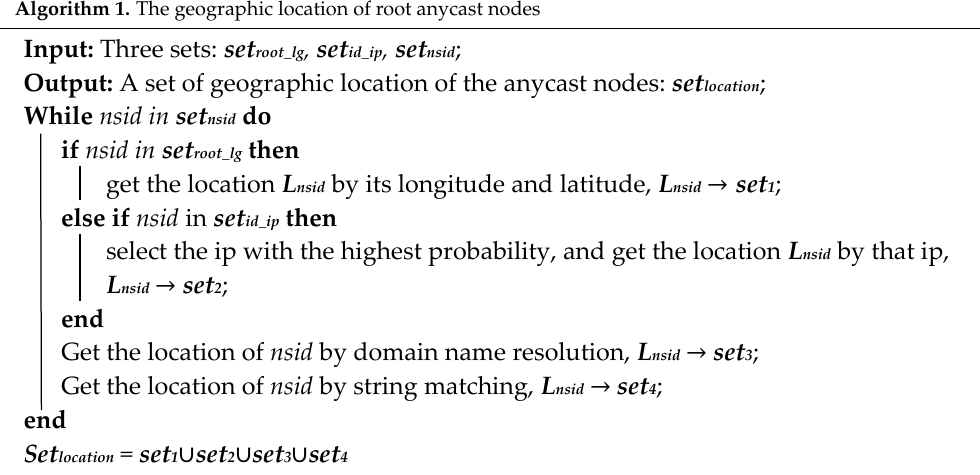
Algorithm 1. The geographic location of root anycast nodes.